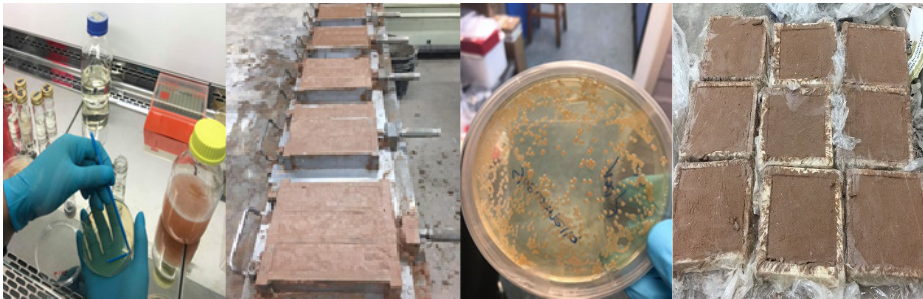
Figure 2. Bioproduct and mortar prismatic and square samples. The square samples are for moisture buffering test.